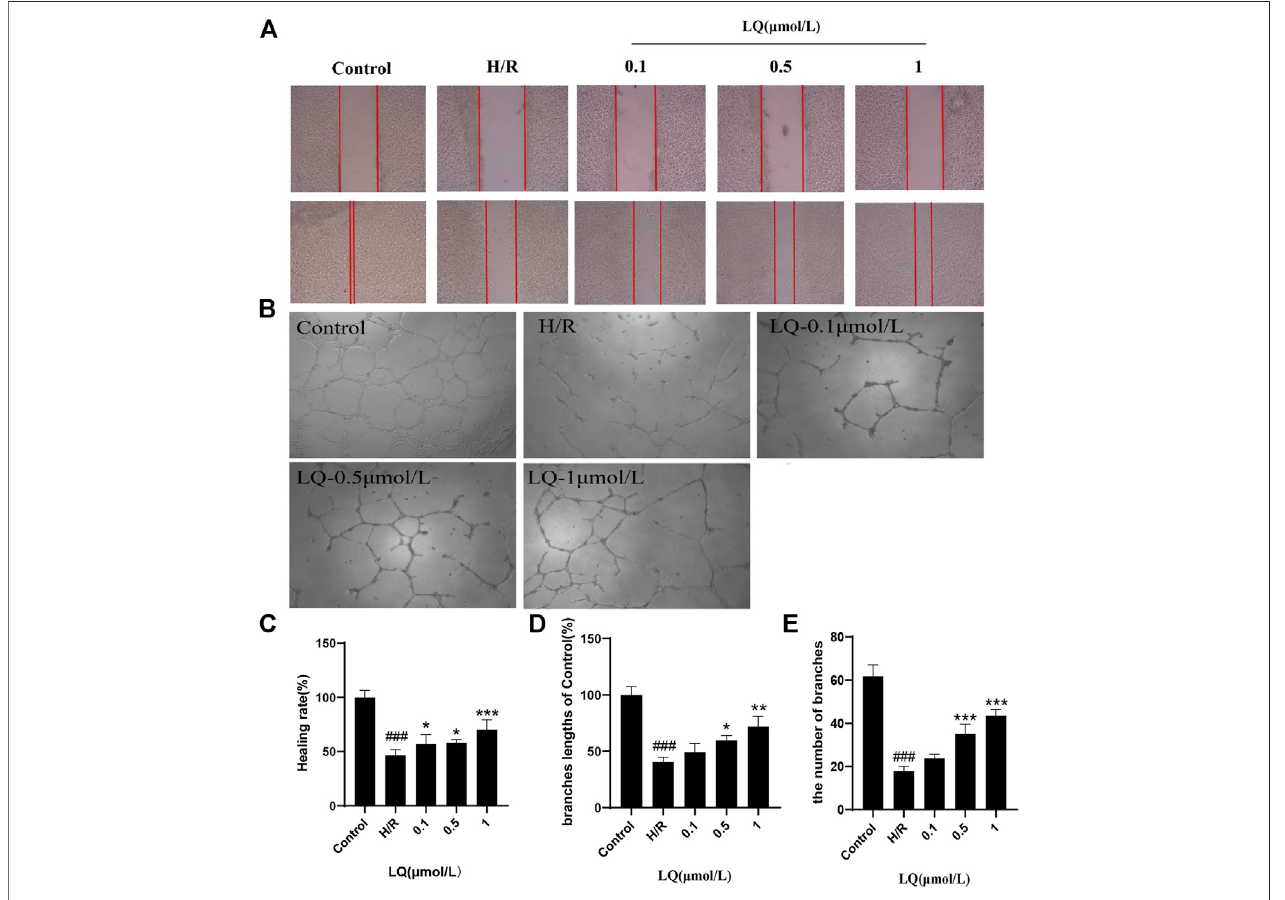
FIGURE 2 | LQ promote migration and tube formation of H/R-HBMECs. (A) The distance between scratches could be reduced in the presence of LQ (0.1, 0.5, 1 μ mol/L). (B) The branches length ofthe tube could be increased by different concentrations of LQ (0.5, 1 μ mol/L). (C) The healing rate data analyze. (D) The branches length of the tube dada analyze. (E) The number of branches of tube data analyze. ### p < 0.001, compared to control. * p < 0.05, ** p < 0.01, *** p < 0.001, compared to H/R.